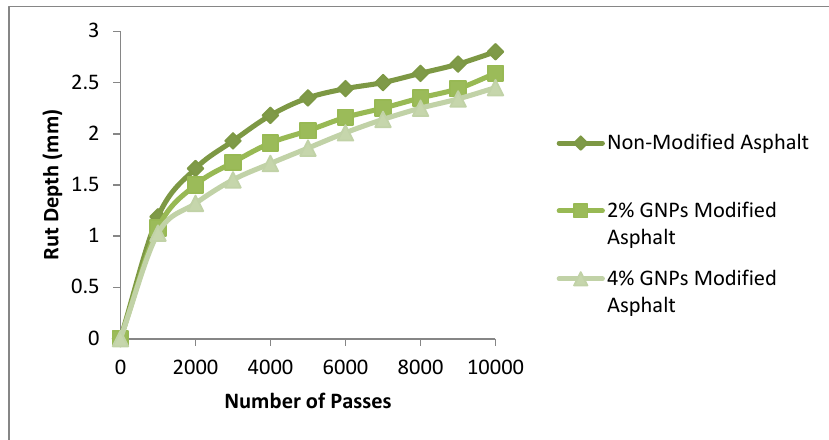
Figure 8. The Wheel Tracking Test results at 40 °C. GNPs = Graphene Nano-Platelets.